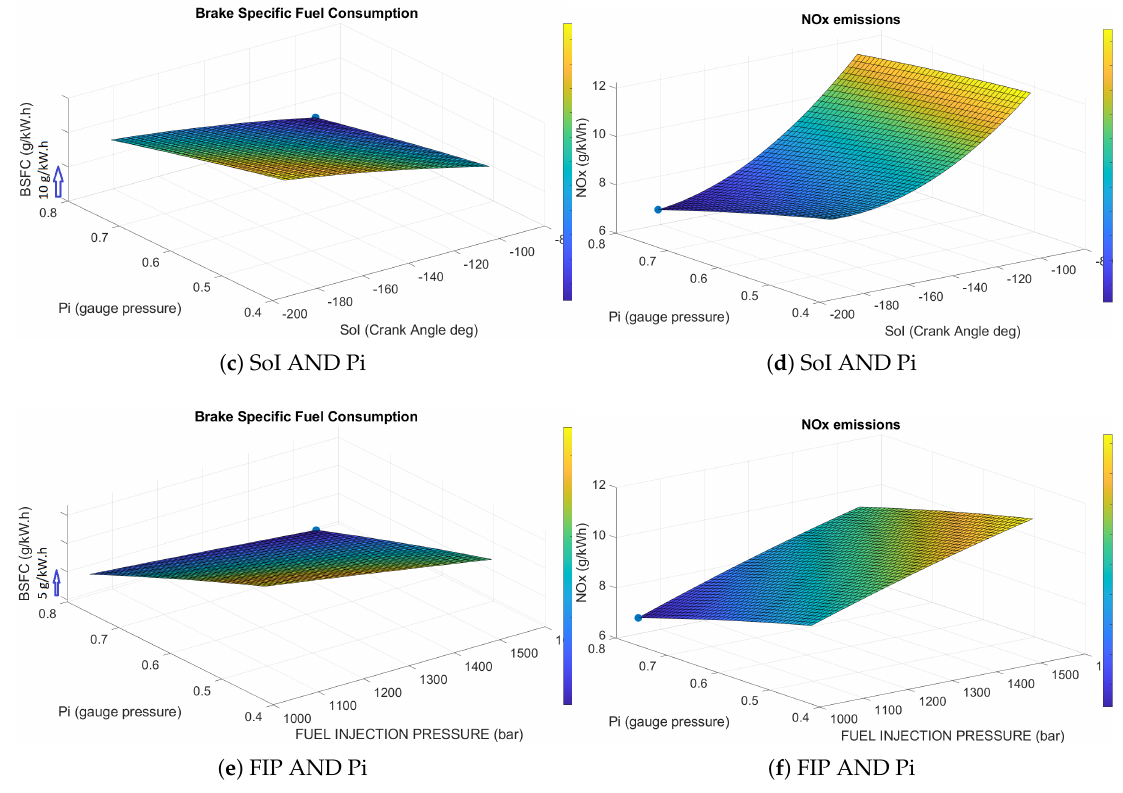
Figure A1. Response surface of the BSFC & NO x at 1000 RPM-200kW.